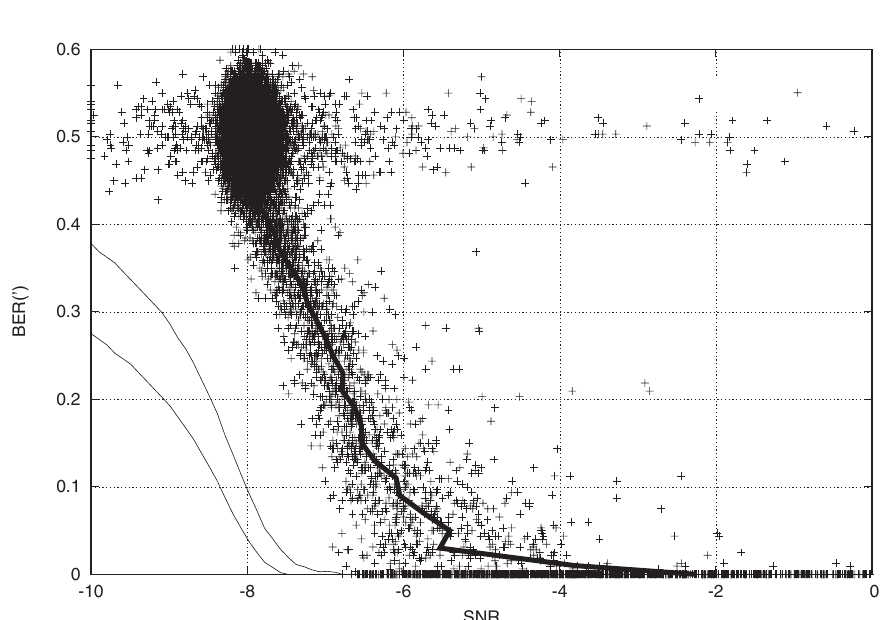
Fig. 7. A figure showing the preliminary results of the spread spectrum based data transmission system. A scat- ter plot of the Signal to Noise Ratio plotted against the Bit Error Rate (BER) measured in 320-bit bursts is de- picted. Every cross corresponds to a single